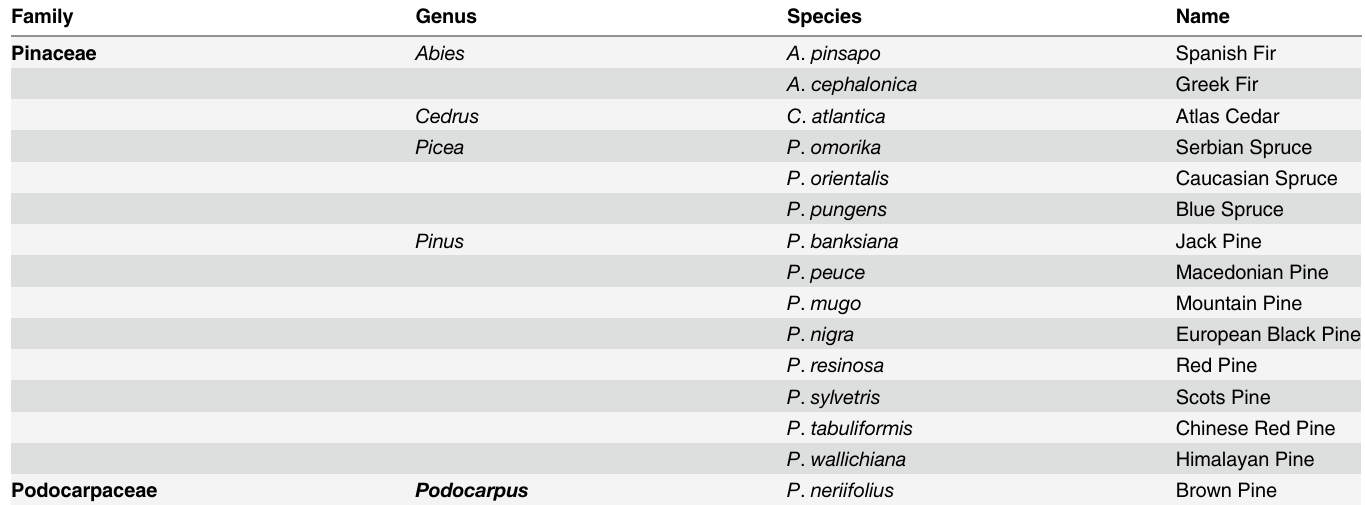
Table 1. List of the pollen samples.